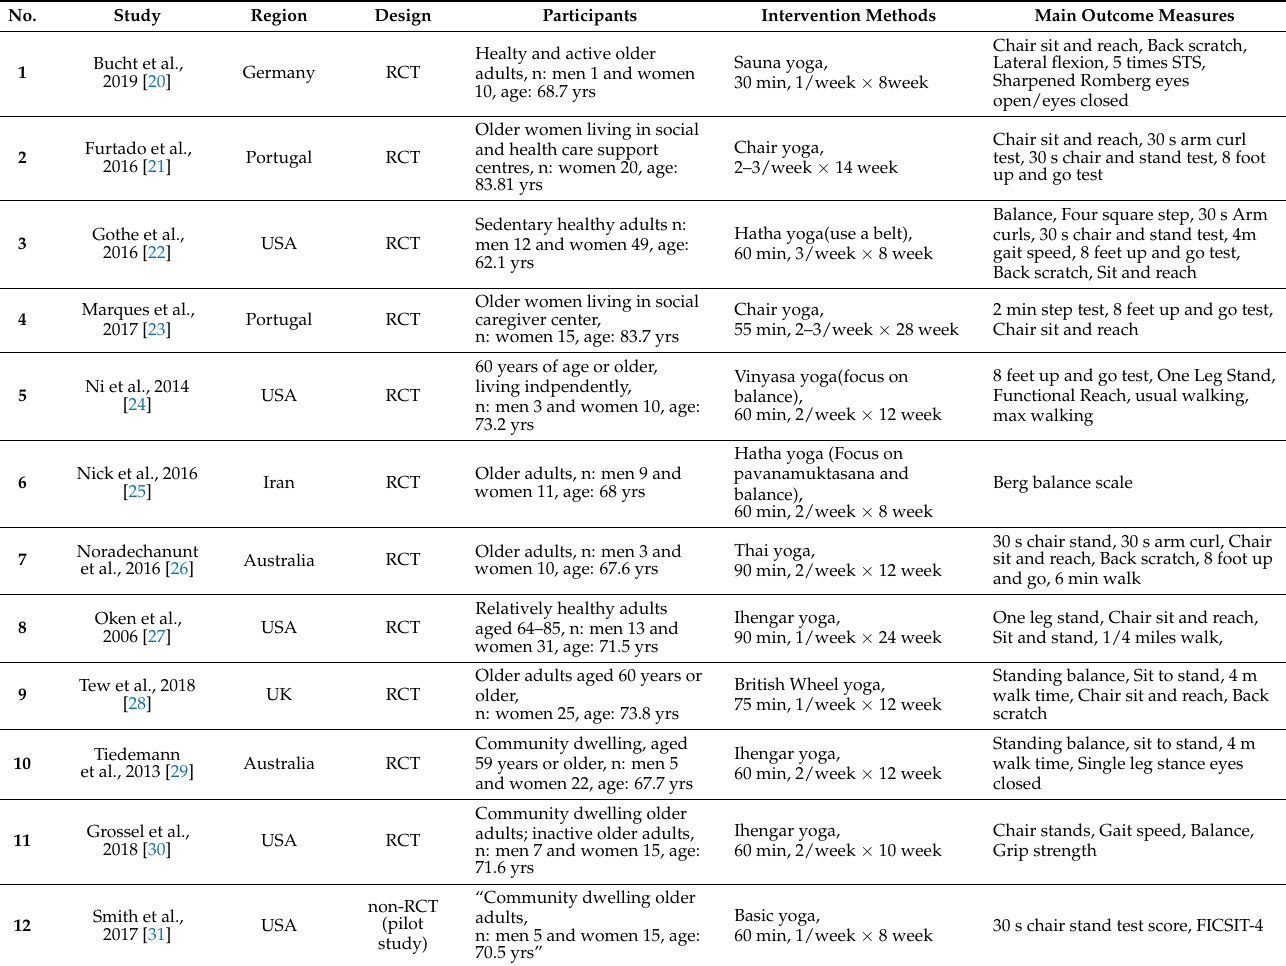
Table 1. Characteristics of research